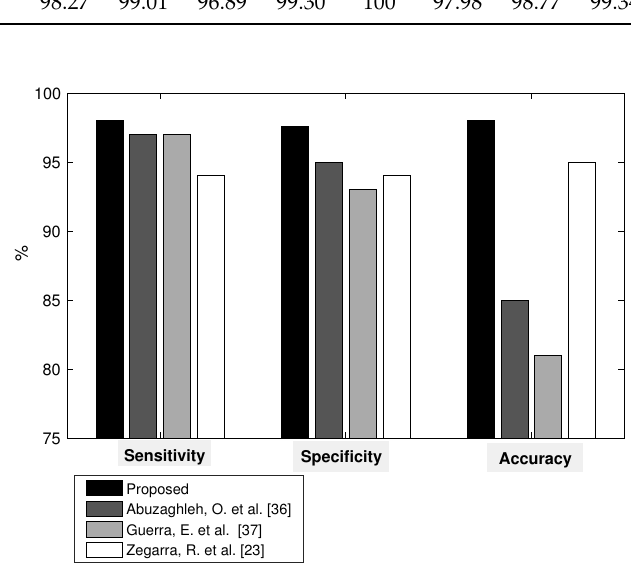
Figure 11. Comparison of efficiency between reported literature and the proposed